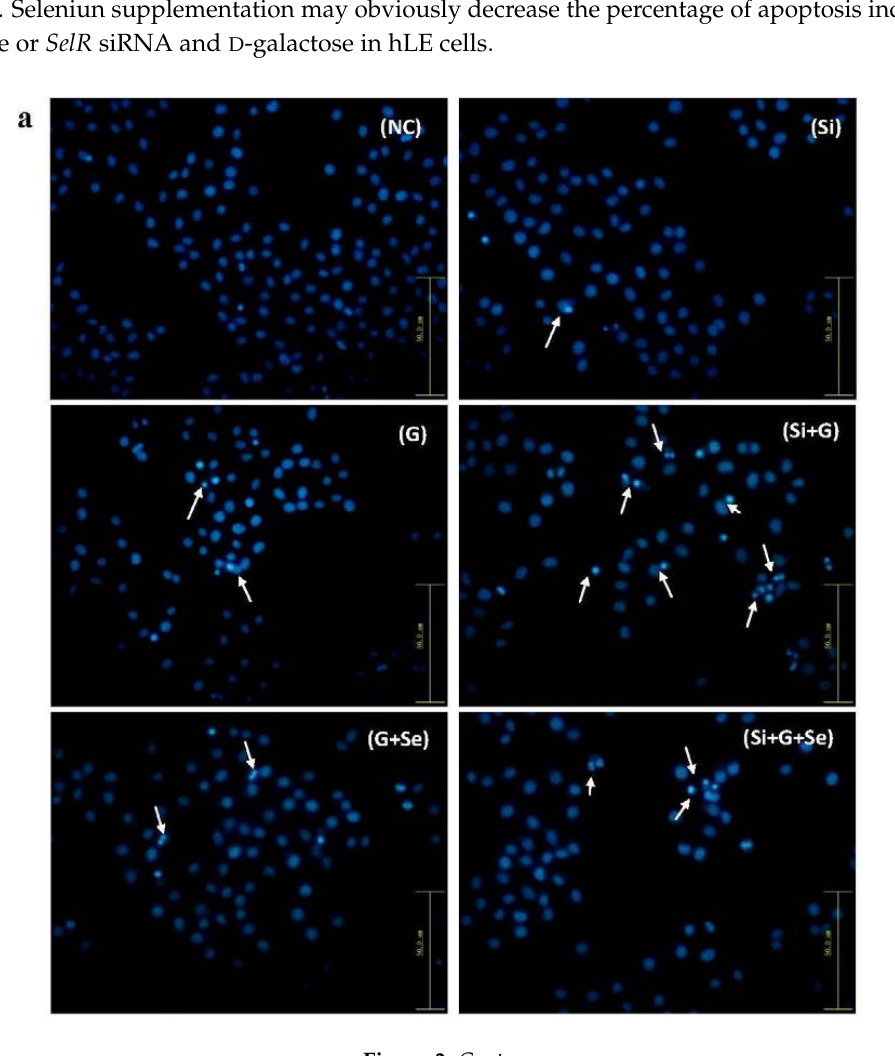
Figure 3. Cont. Figure 3.